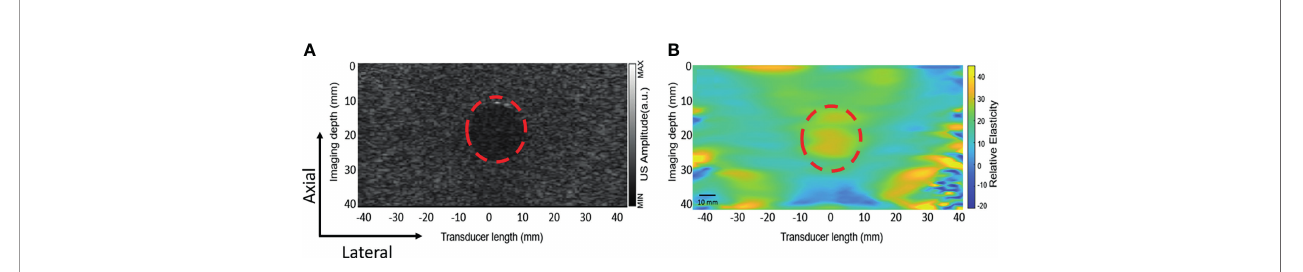
FIGURE 5 | Elastography result obtained from the gelatin phantom. The red dashed circle highlights a cylindrical inclusion with a different elasticity than the surrounding medium. (A) The ultrasound B mode image. (B) The elastic modulus map obtained by uniaxial quasi-static compression.